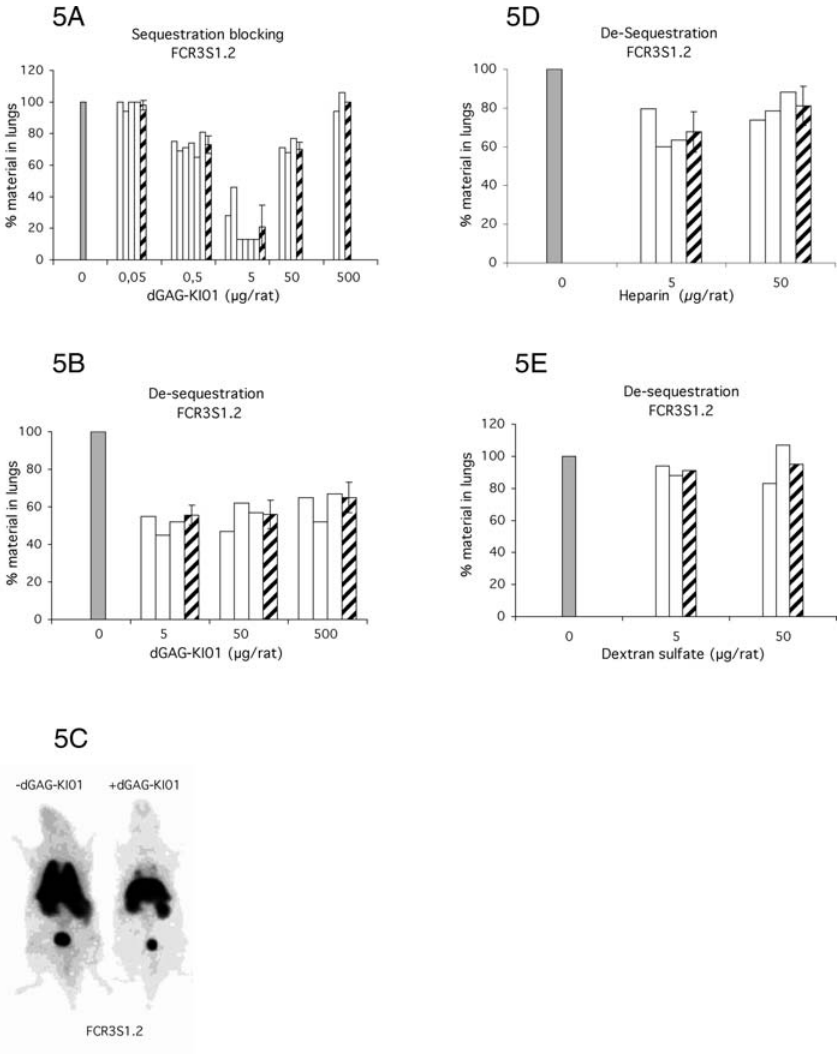
Figure 5. Injection of dGAG-KI01 into Rats Prevents Sequestration of P. falciparum (FCR3S1.2) IE in the Lungs (A) and (B) Rats received either 99m Tc-labeled IE simultaneously with different concentrations of the dGAG-KI01 (sequestration blocking) (A), or were first injected with 99m Tc-labeled IE and, after three min, injected with dGAG-KI01 (de-sequestration) (B). (C) Whole-body summary images of rats captured 21–30 min after the injection of 99m Tc-labeled IE alone ( (cid:1) dGAG-KI01) or when co-injected with 5 l g of dGAG-KI01 ( þ dGAG-KI01). (D) and (E) Rats were injected with 99m Tc-labeled IE and subsequently with heparin (D) or the sulfated polysaccharide dextran sulfate (E). Rats were in all cases left in the gamma camera for 30 min after which the lungs were excised, measured for radioactivity, and compared to the level of radioactivity in the whole animal. Results are presented as relative amount in lungs compared with control animals receiving no dGAG-KI01, heparin, or dextran sulfate (control, adjusted to 100%; grey bars). White bars show the results of individual rats, and striped bars, the mean